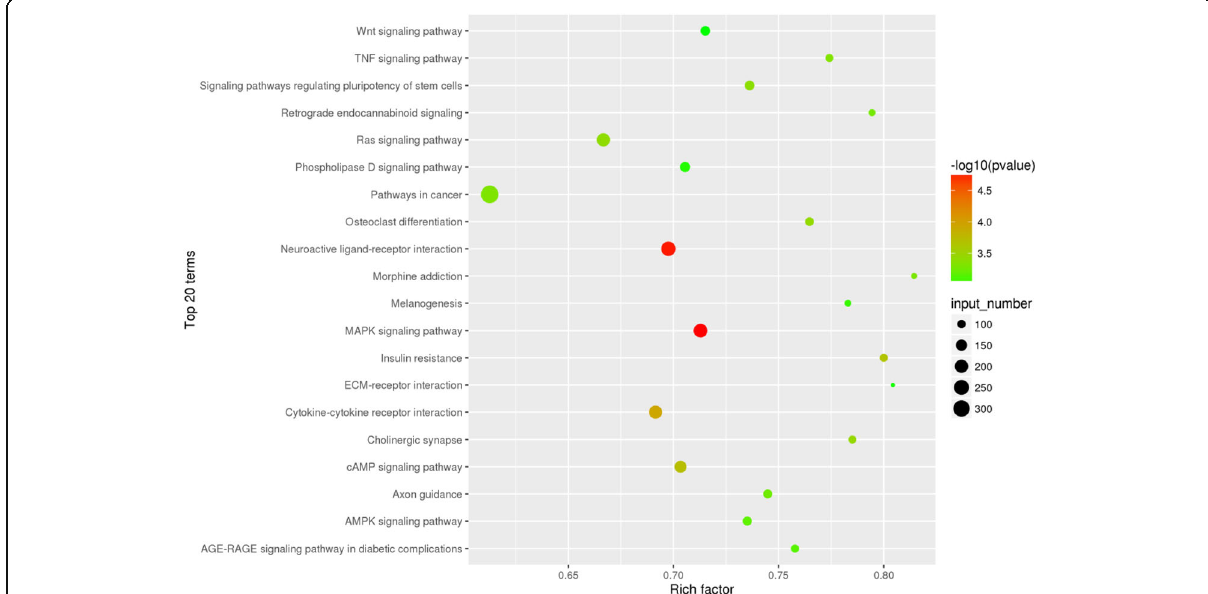
Fig. 6 Top 20 KEGG pathways for target gene of differentially expressed miRNAs. The circle size represented gene number. Q value was shown by color